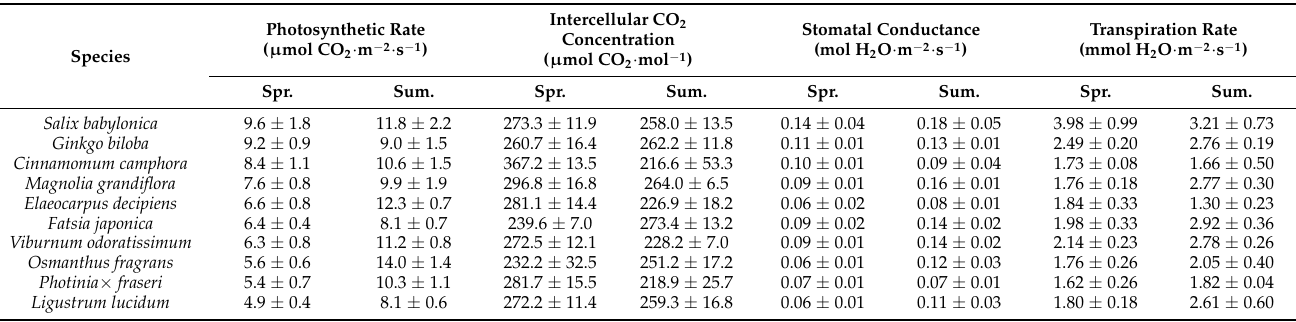
Table 1. Photosynthesis and related physiological parameters. Species are listed in decreasing order of photosynthetic rate in spring.